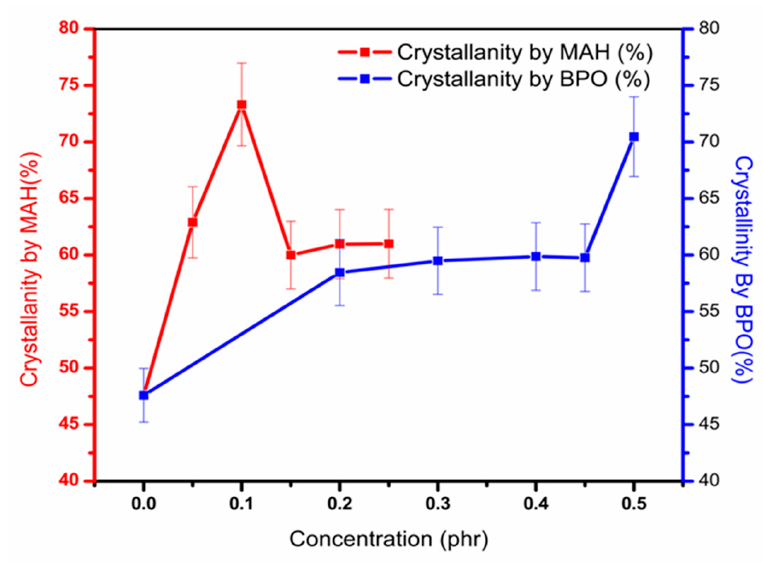
Figure 6. Effect on percentage crystallinity for grafted samples by varying MAH and BPO content.